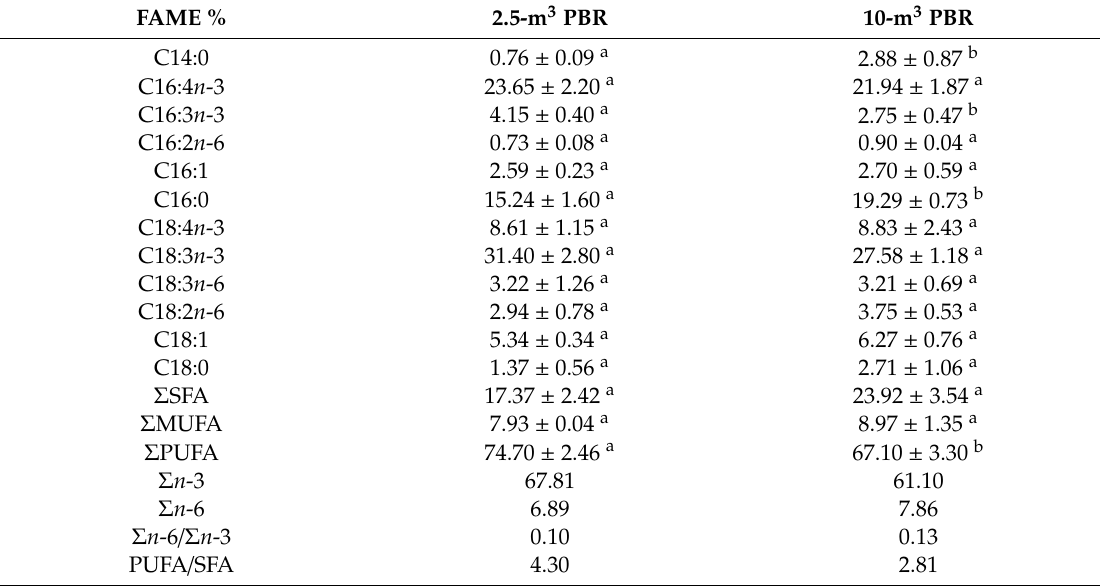
Table 3. Fatty acid methyl esters (FAME) profile of Chlorococcum amblystomatis biomass grown in 2.5- and 10-m 3 tubular photobioreactors (PBR). Di ff erent letters indicate significant di ff erences between reactors. Values are given as means ± standard deviation ( n = 3).